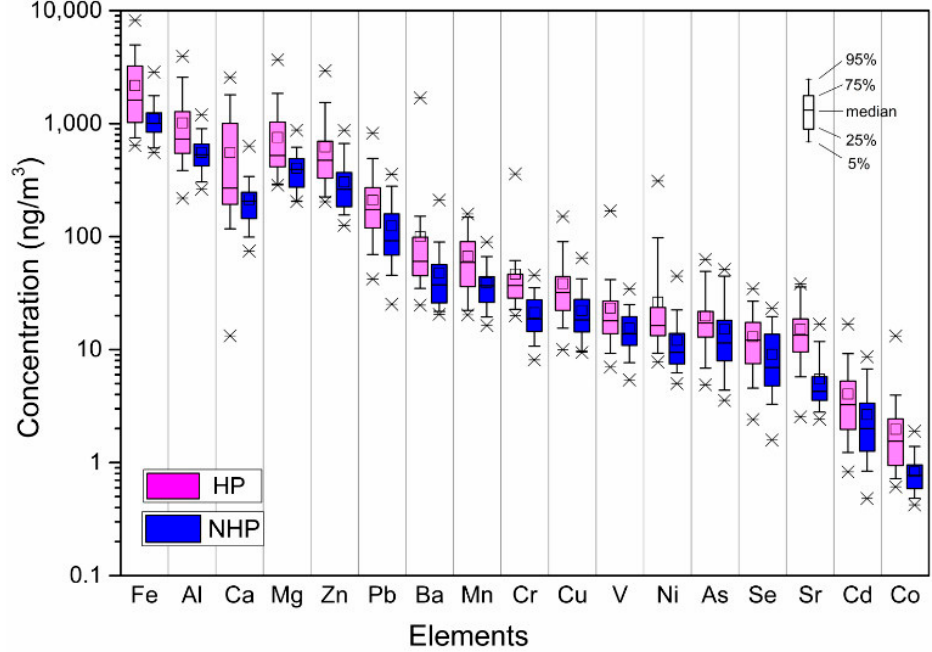
Figure 2. Concentrations of PM 2.5 -bound elements during the heating period (HP) and non-heating period (NHP). period